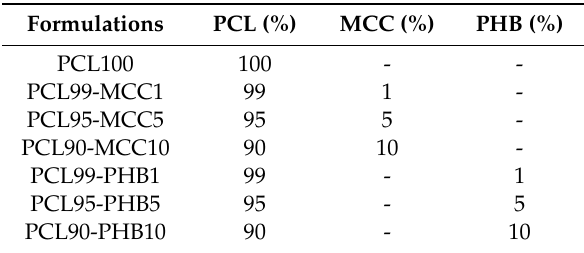
Table 1. Electrospun PCL-based formulations.